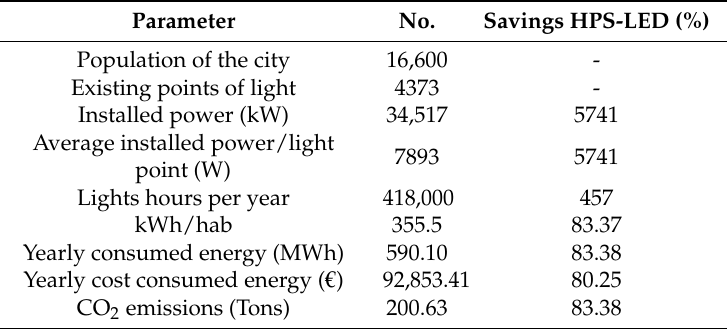
Table 2. Data of the same public lighting